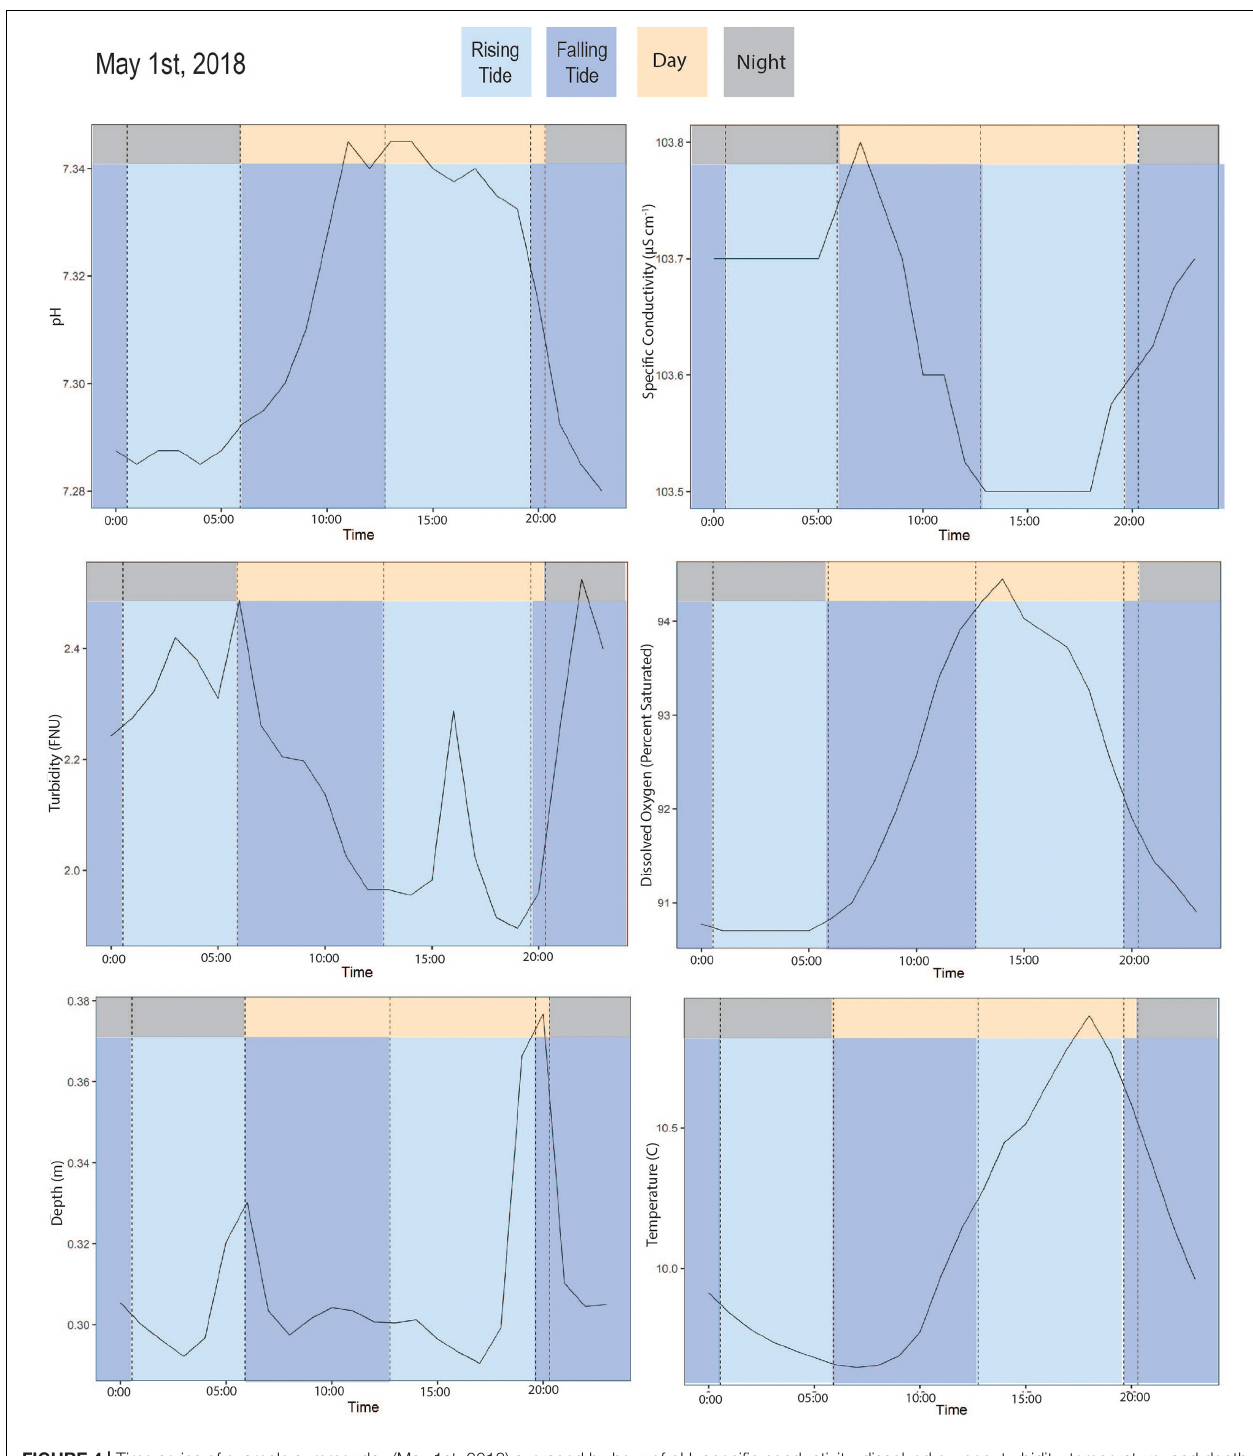
a constant depth since bathymetric data is unavailable, we conservatively estimate a water transit time of 6 h between the sensor and the river mouth; using a width of 7 m